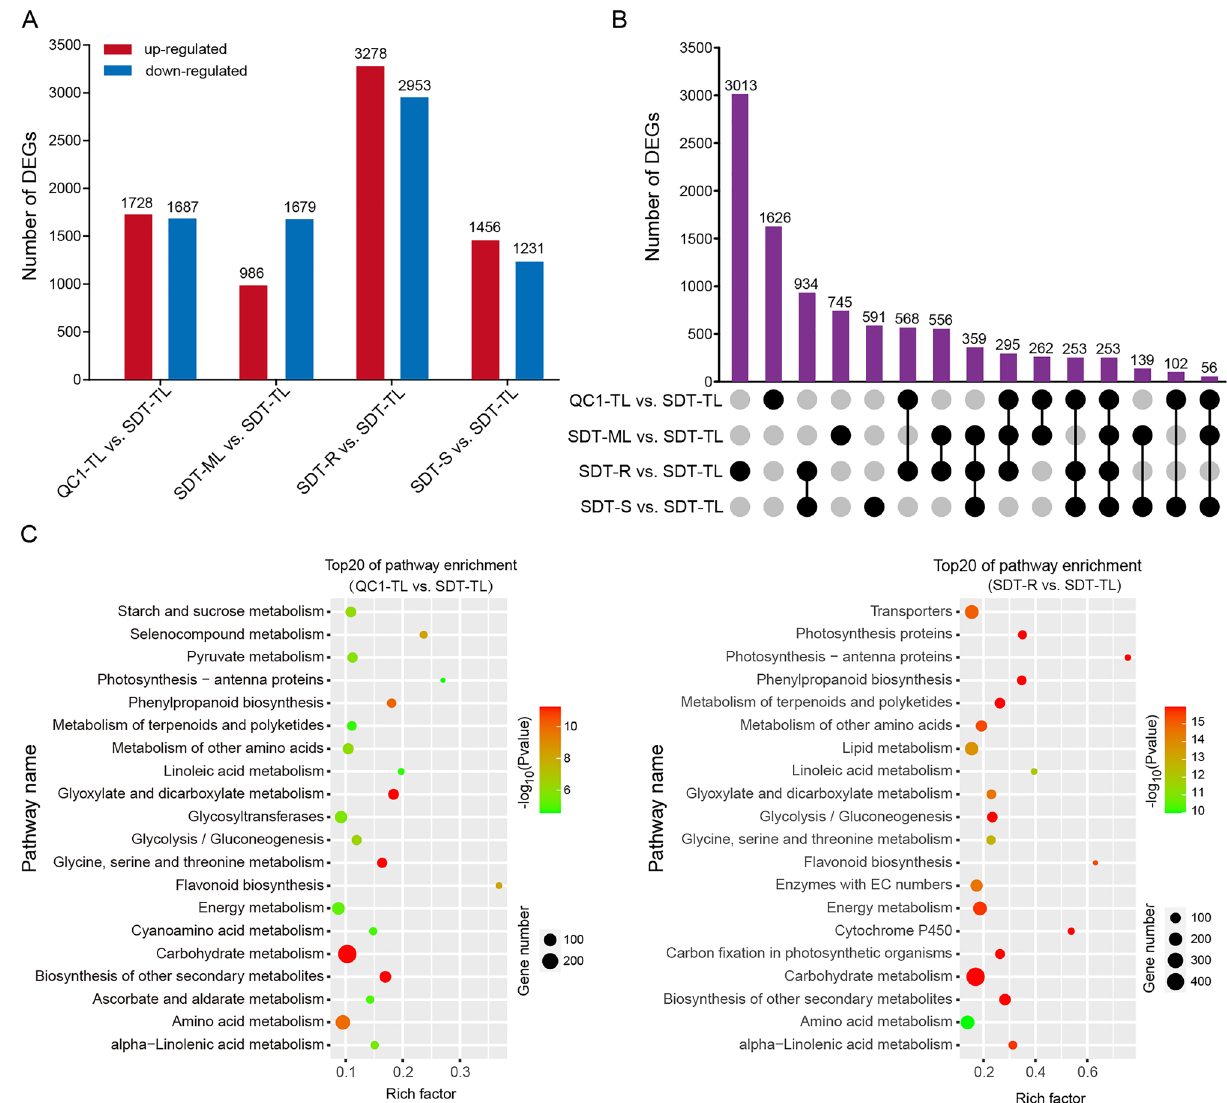
Figure 4. Analysis of differentially expressed genes (DEGs) by RNA-seq. ( A ) Statistics of DEGs in different samples. ( B ) Common and specific DEGs identified by upset venn diagram analysis. ( C ) KEGG enrichment analysis of DEGs in SDT-TL vs. QC1-TL and SDT-TL vs. SDT-R groups (p < 0.01). The size and color of the circles represent the number of DEGs and p-values, respectively. The x-axis represents the rich